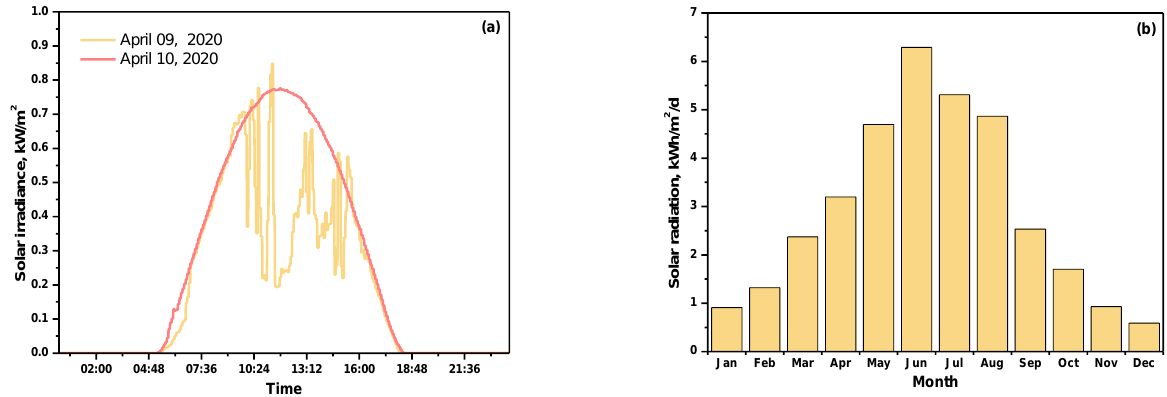
Figure 2. Solar radiation for the days of 9 and 10 April 2020 ( a ) and monthly averaged solar irradiance ( b ). Ambient temperature: Thermocouples on the Krakow AGH University of Science and Technology campus measured ambient temperature experimental data with a 1 min temporal resolution from 1 January to 31 December 2020. The annual average ambient temperature was approximately 10.7 ◦ C and the highest average monthly temperature was 21.9 ◦ C in July, while the lowest average monthly temperature was − 3.0 ◦ C in